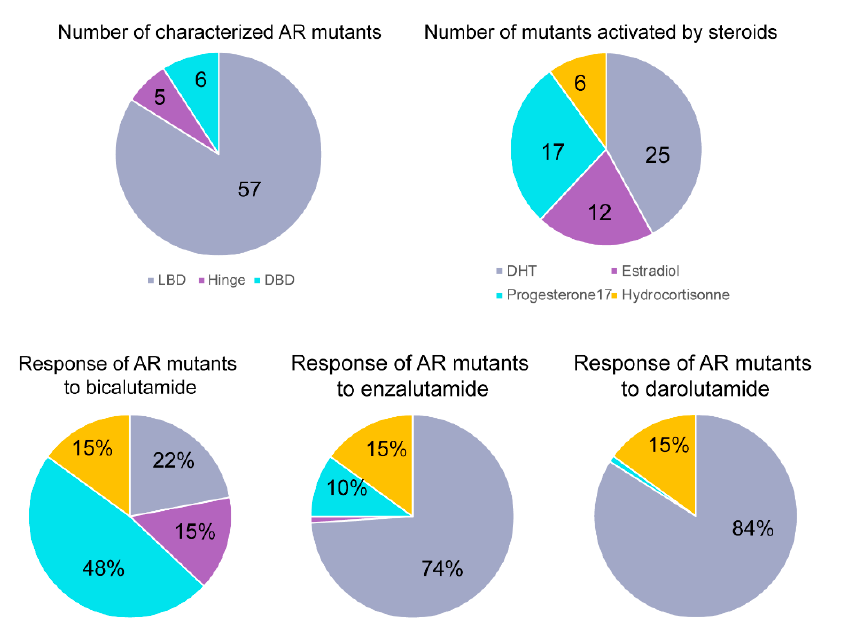
Figure 4. Summary of functional characterization of AR mutants. We functionally characterized 68 AR mutants, mainly in the LBD, and few in the DBD and Hinge regions. Twenty-five of the studied mutants were activated by DHT, 12 by estradiol, 17 by progesterone and 6 by hydrocortisone to higher levels than wild-type AR. AR mutants showed different response profiles in presence of first- (bicalutamide) and second (enzalutamide)-generation AR antagonists and the newly approved darolutamide. Of the characterized mutants, 15% did not show any activity in our assay.